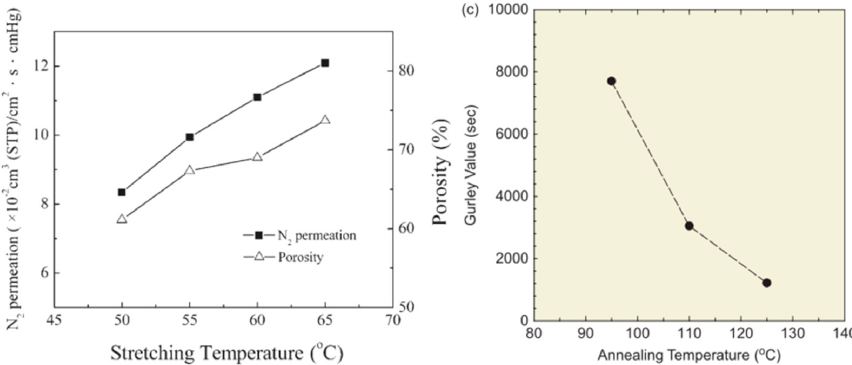
Figure 13. ( Left ): Effect of the stretching temperature on N 2 permeation flux and porosity [22] . ( Right ): Effect of the annealing temperature on the Gurley value, adapted from [99] .